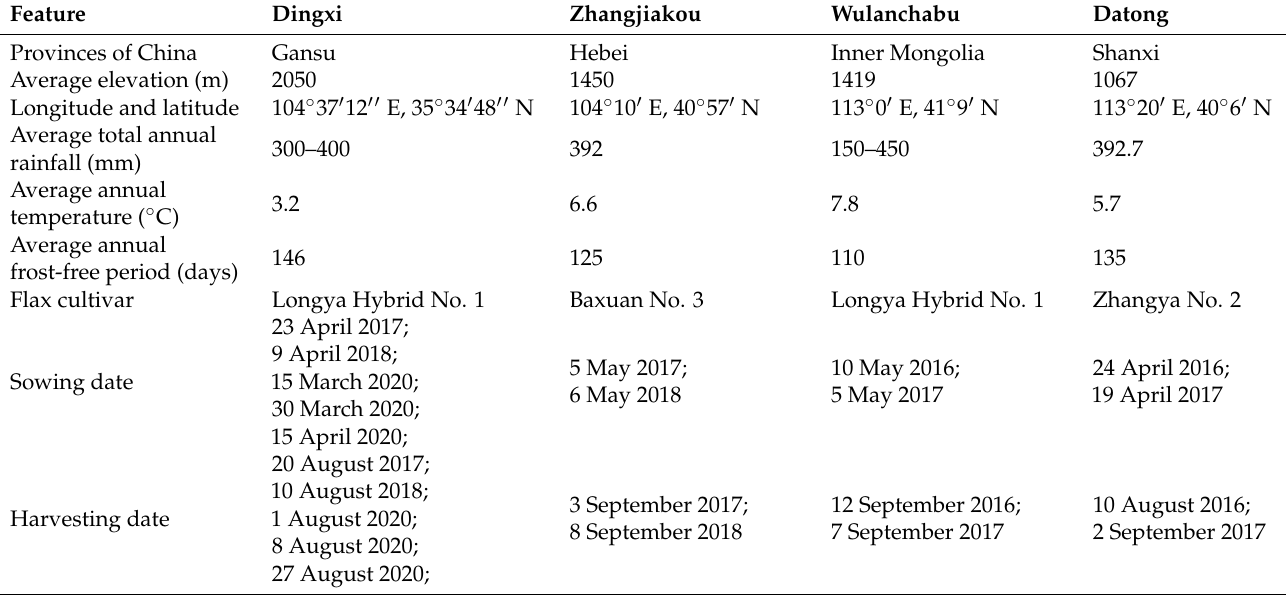
Table 1. Detailed features of the four sites where the trials were